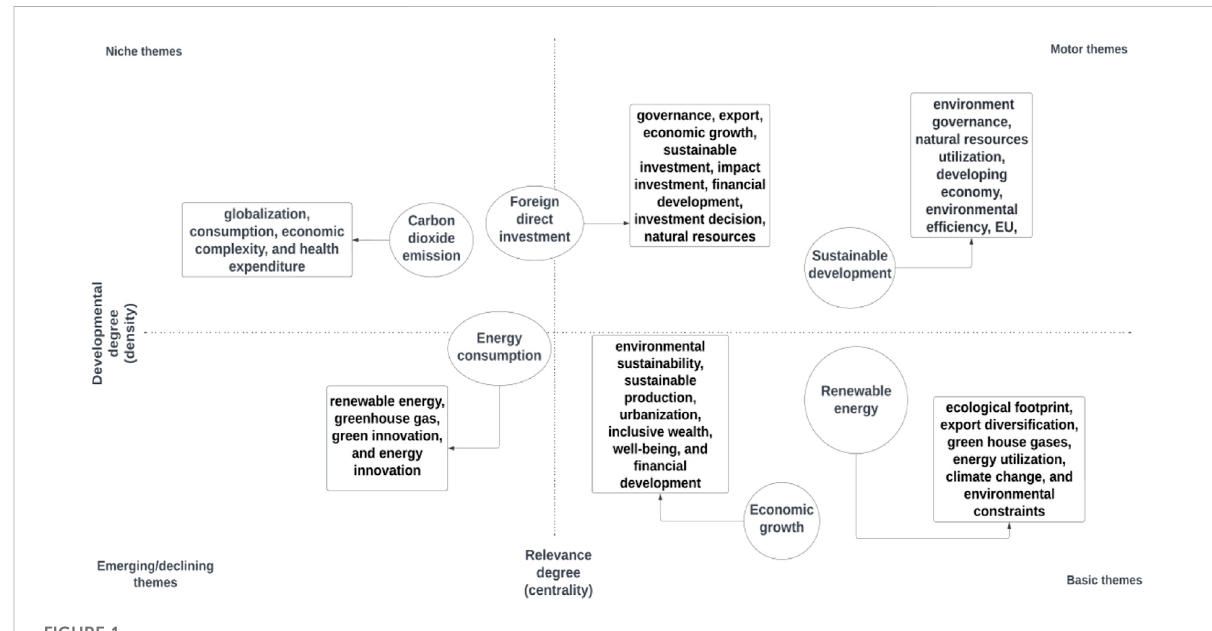
FIGURE 1 Strategic